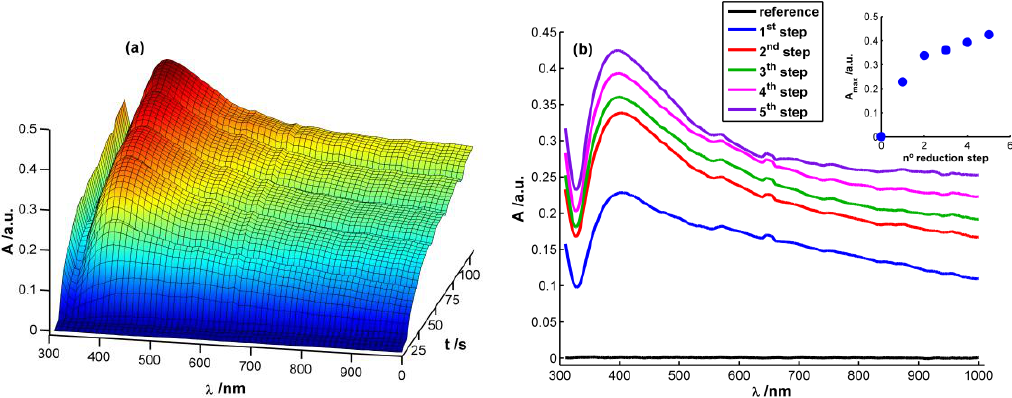
Figure 2. ( a ) UV/Vis spectra temporal evolution during the galvanostatic multipulse synthesis of Ag NPs. ( b ) Spectra at the end of each reduction step (inset: maximum of absorbance at the end of each reduction step). Experimental conditions as in Figure